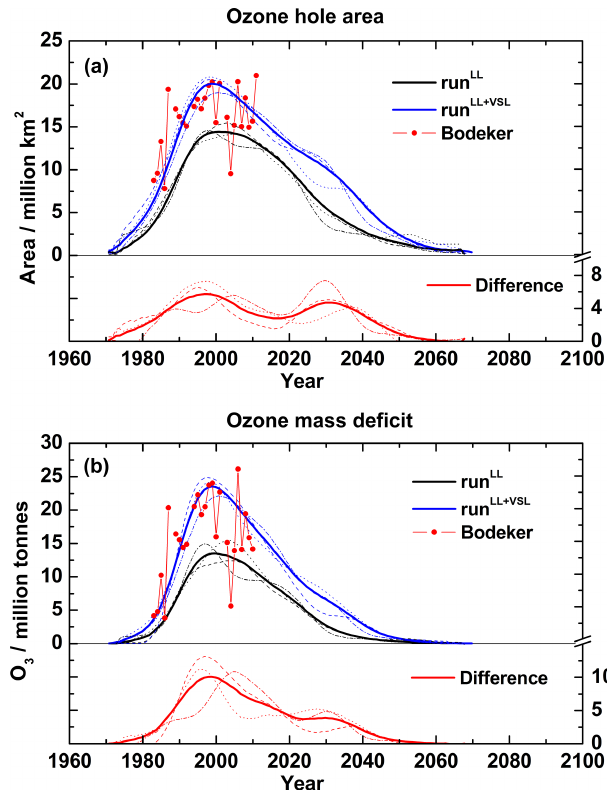
Figure 5. Temporal evolution of the ozone hole area (a) and ozone mass deficit (b) for both experiments (black for run LL and blue for run LL + VSL ) on the left axis, as well as the difference between runs (red) on the right axis. Solid thick lines show the ensemble mean for each experiment, while the dashed, dotted and dashed–dotted thin lines correspond to each of the three independent simulations (sim 004 , sim 005 and sim 006 ) for each